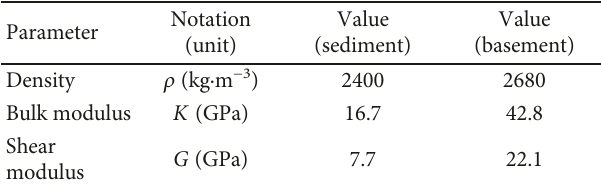
Table 1: Mechanical parameters for the rock matrices. Parameter